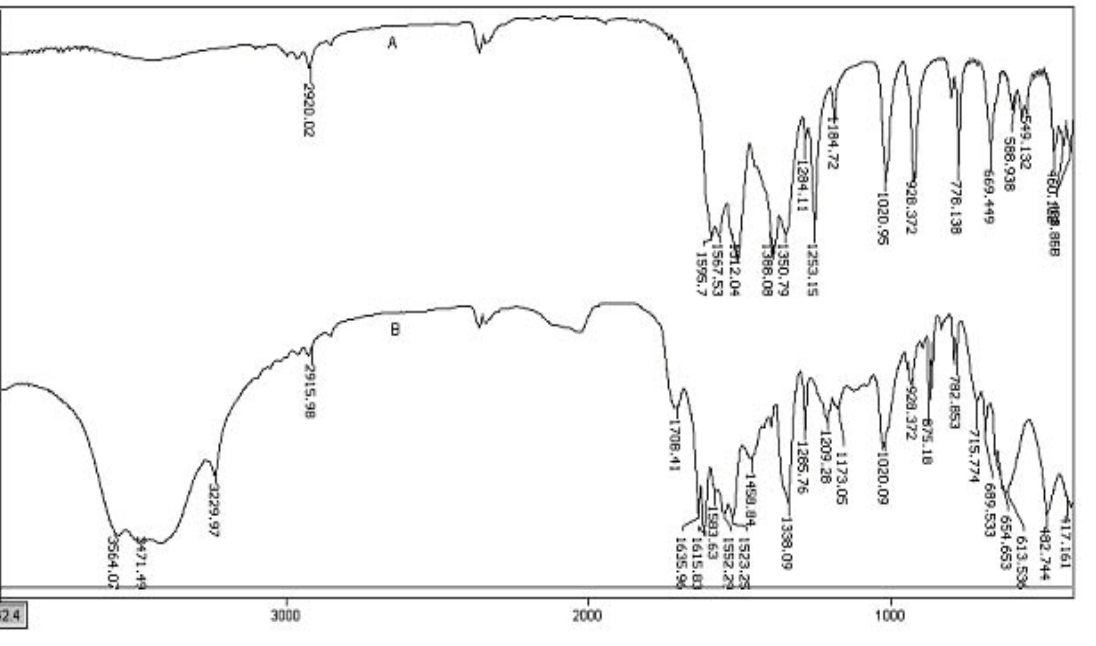
Carbon (in %) found found